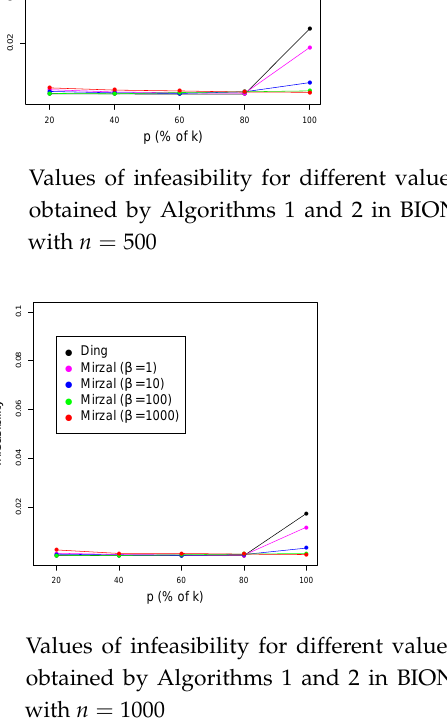
Figure 4. This figure contains six plots which illustrate the quality of Algorithms 1–3 regarding the infeasibility on BION instances with n = 100,500,1000 and k = 0.2 n , 0.4 n , for β ∈ { 1,10,100,1000 } . We can observe that Algorithm 3 computes solutions with infeasibility (18) slightly smaller compared to solutions computed by Algorithm